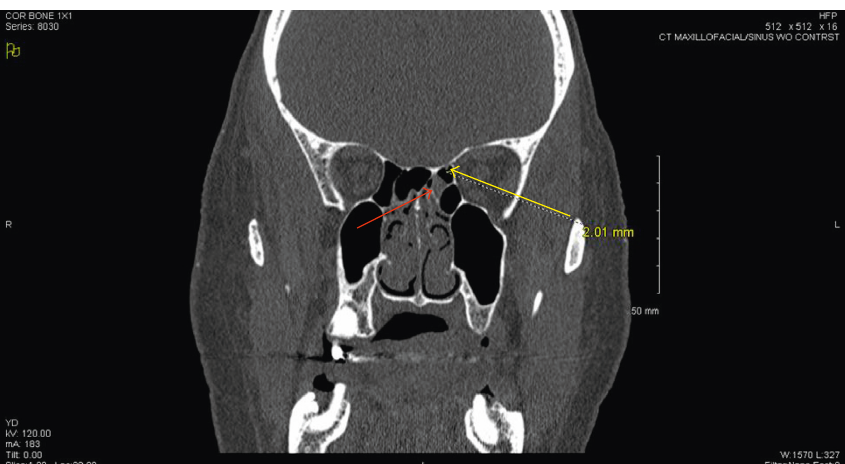
Figure 1: High-resolution CTshowing area suspicious for a small skull base defect (yellow arrow) and adjacent opacification in the posterior ethmoid sinus (red